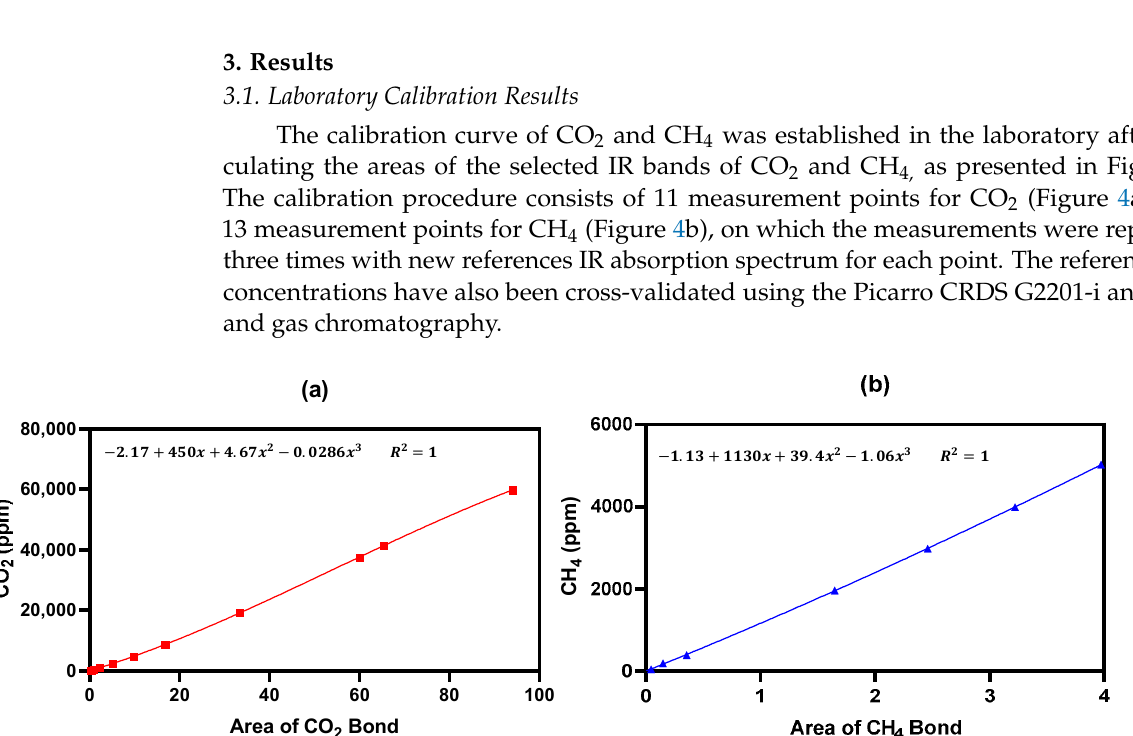
Figure 3. A vertical section of the soil profile of Tithonian limestone surmounted by valanginian sediments. On the surface, borehole measurement and a lattice tower (FT) were constructed with the distance around 355 m.